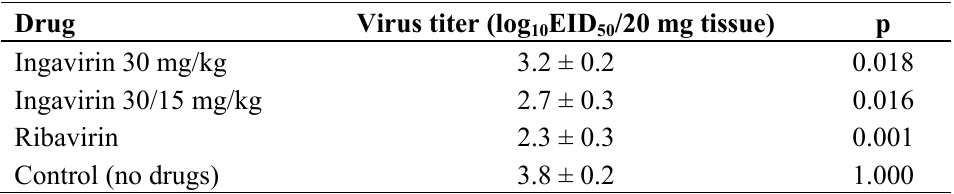
Table 2. Infectious activity of hPIV in lung tissue of Syrian hamsters after application of Ingavirin.